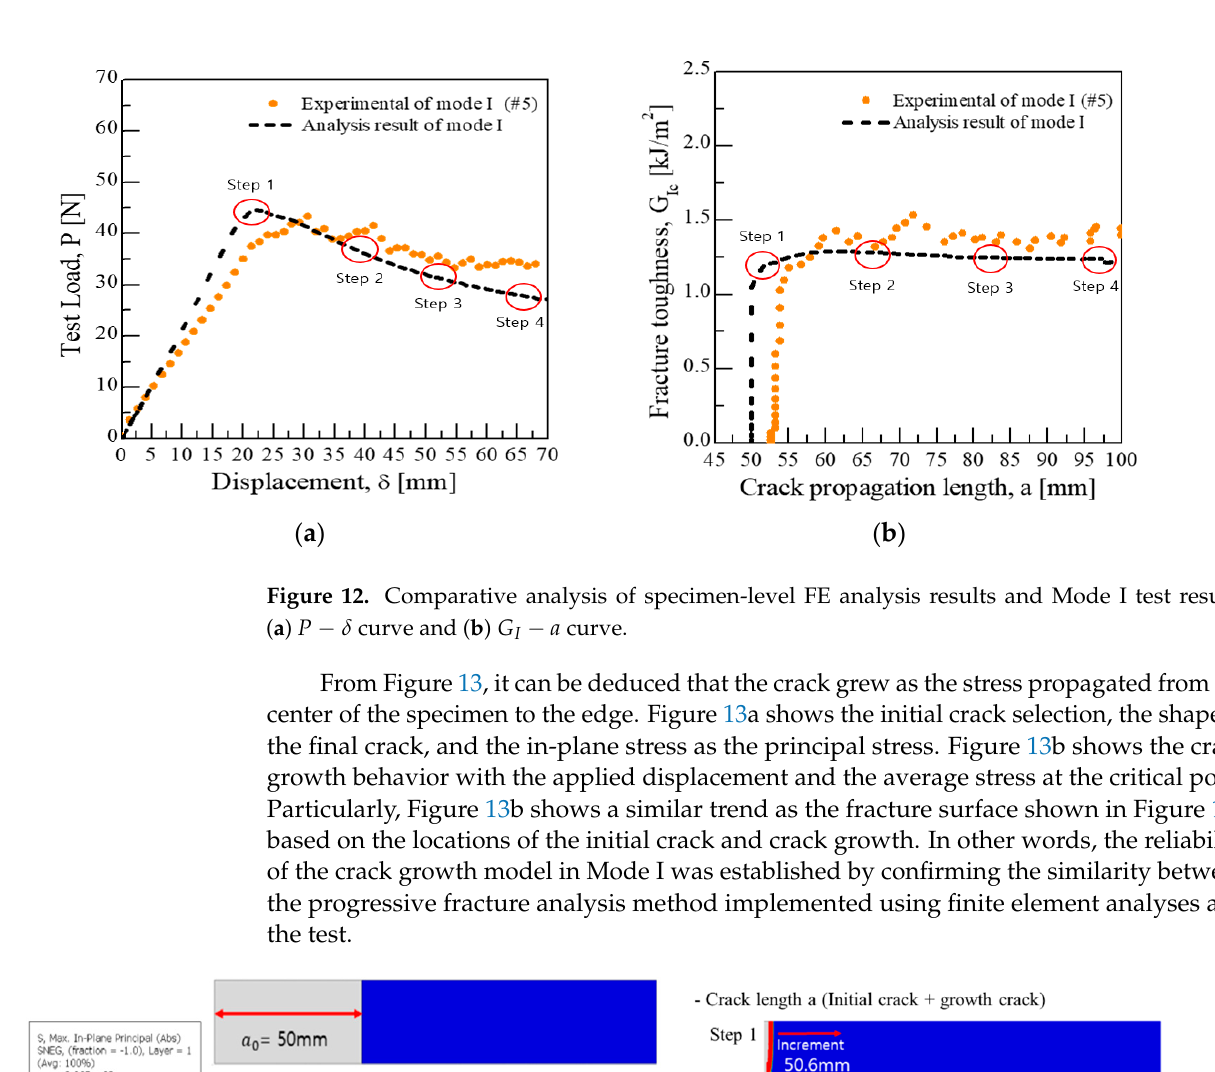
( b ) Figure 11. Fracture cross-section of Mixed-mode test results: ( a ) c = 82.9 mm, mode mixture ratio = 0.23; and ( b ) c = 31.2 mm, mode mixture ratio = 0.64. 3.2. FE Analysis for Mode I, Mode II, and Mixed-Mode Tests To analytically evaluate the crack growth behavior according to each test mode, the fracture toughness was calculated under the same test conditions, as shown in Table 6. Through NL analysis for each test mode, we selected values of 1.12 kJ/m 2 and 2.02 kJ/m 2 for Modes I and II, respectively. For Mode III, we used the same value as Mode II [27]. In addition, for the Mixed-mode, we selected a material factor of 1.85. First, in Figure 12a,b, which show the displacement–load curve as the analysis result under Mode I conditions